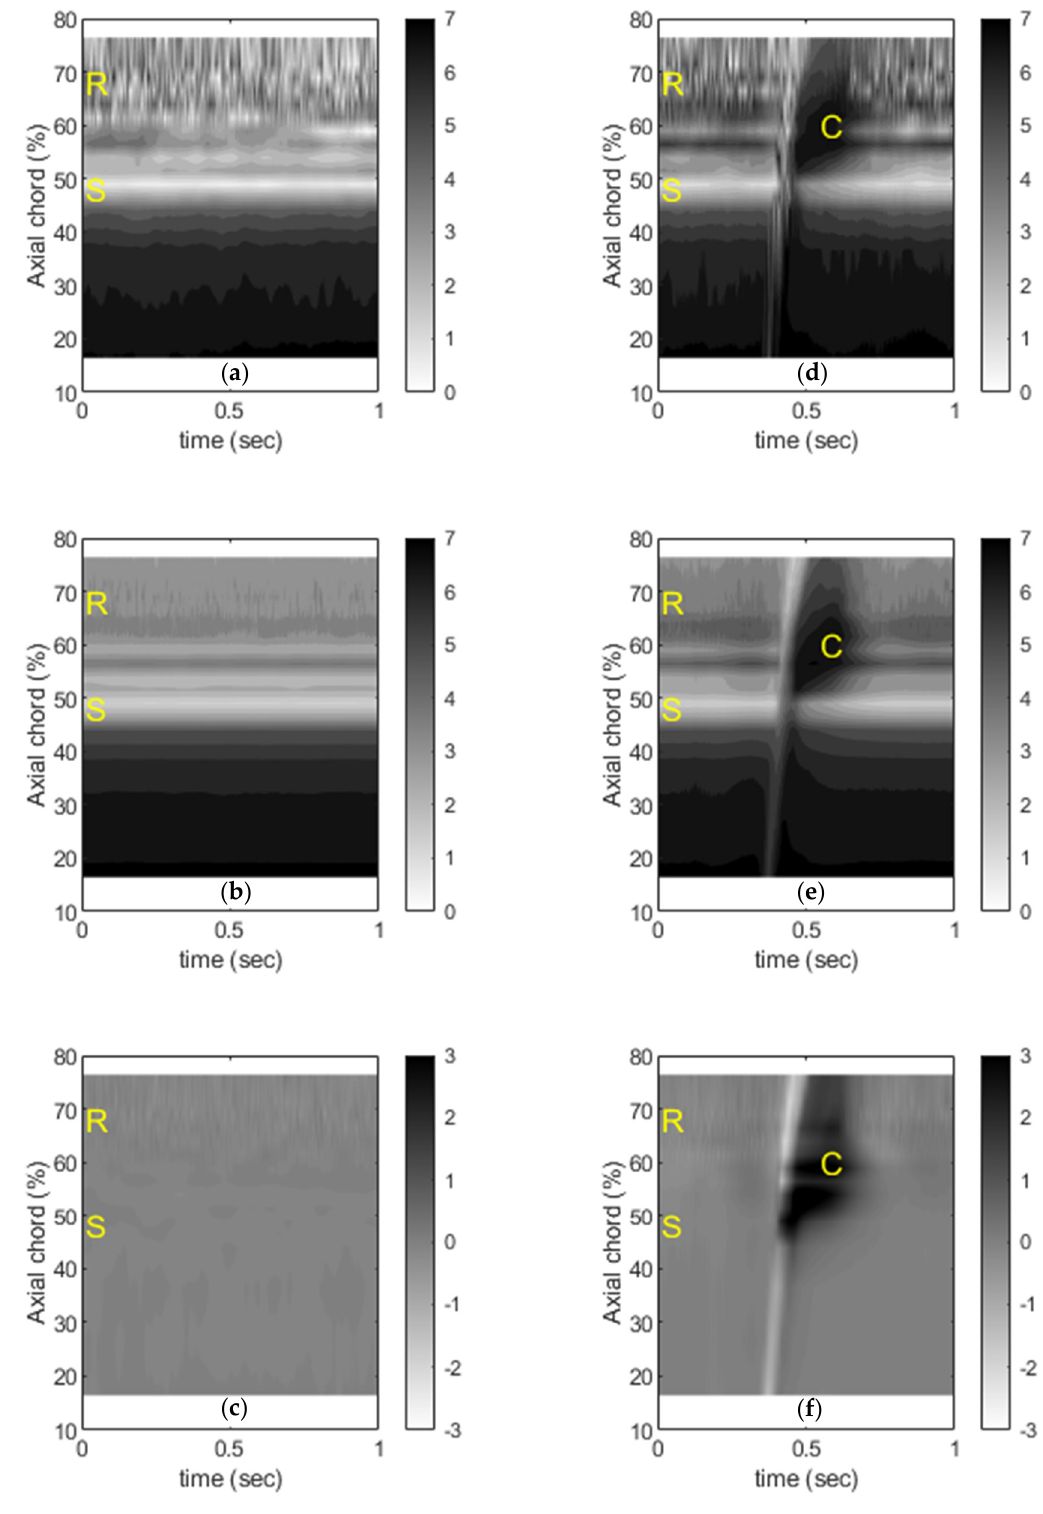
Figure 5. S–T diagram of hotwire signals acquired along the locus of peak u rms . Raw signals are shown first for ( a ) steady-inlet and ( b ) wake-inlet. Ensemble averaged signals are presented next for ( c ) steady-inlet and ( d ) wake-inlet. Finally, the ensemble averaged effect due to the disturbances alone is shown by subtracting the mean steady flow for ( e ) steady-inlet and ( f ) wake-inlet. S and R represent the approximate locations of flow separation and reattachment from the current measurements. C represents the ‘calmed region’.